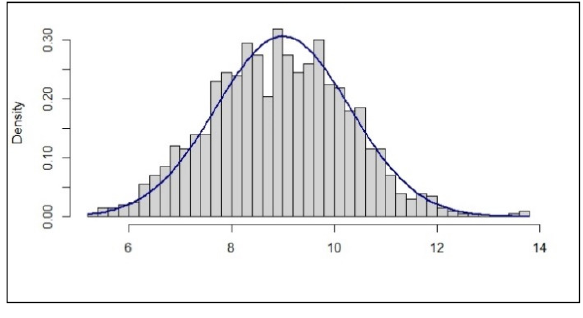
Figure 2. Example of data distribution.